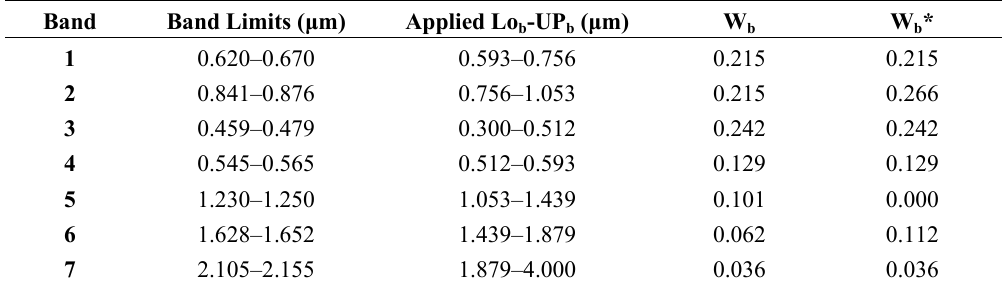
Table 2. Weighting coefficients based on at-surface solar radiation.